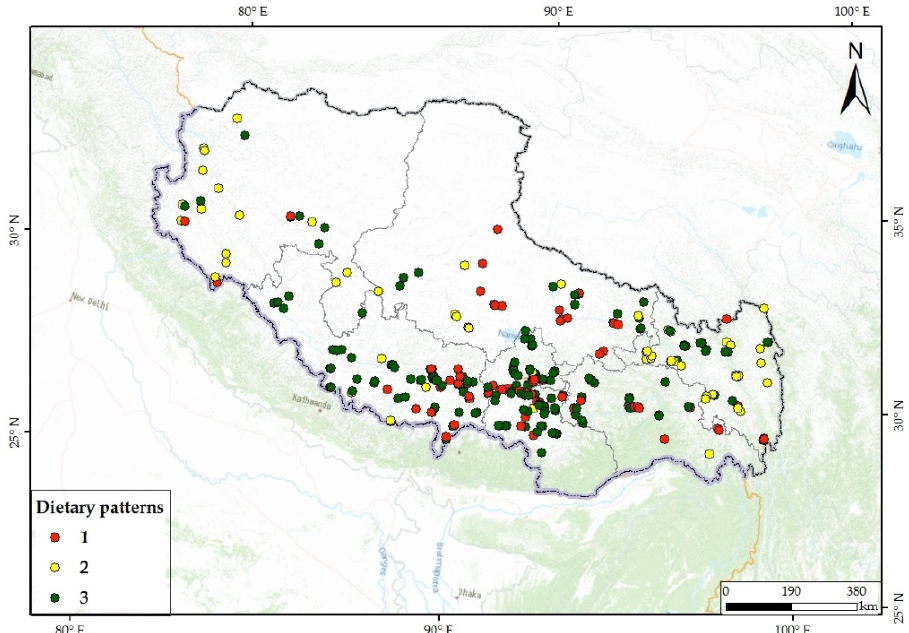
Figure 3. Dietary patterns of subjects in each investigation point. Mode 1: staple food, fruits, and vegetables; Mode 2: staple food, meat, and milk; Mode 3: staple food.